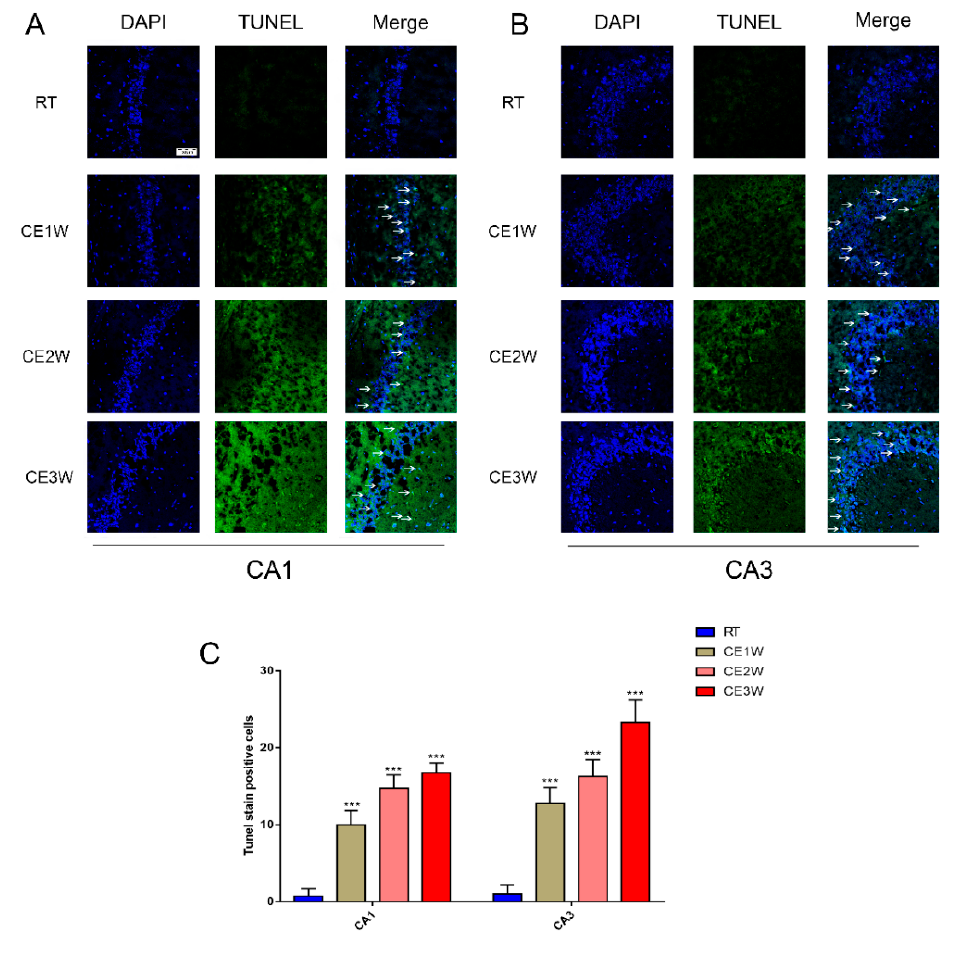
Figure 4. The number of apoptosis cells in the CA1 and CA3 hippocampus regions of each group was directly viewed and counted by TdT-mediated dUTP Nick-End Labeling (TUNEL) staining. The results of TUNEL staining indicated TUNEL (green) staining positive cells counterstained with 4’,6-diamidino-2-phenylindole (DAPI) (blue) in the CA1 and CA3 regions ( B ) of the hippocampus ( A ) in each group. Scale bar = 50 µ m. The apoptotic cells were counted and showed that the number of TUNEL-positive cell in hippocampal CA1 and CA3 regions ( C ) of each group. Data were between RTM vs. CE1W, CE2W, and CE3W groups and were analyzed by one-way analysis of variance. The results are expressed as the mean ± SD ( n = 3) of four independent groups. *** p < 0.001.